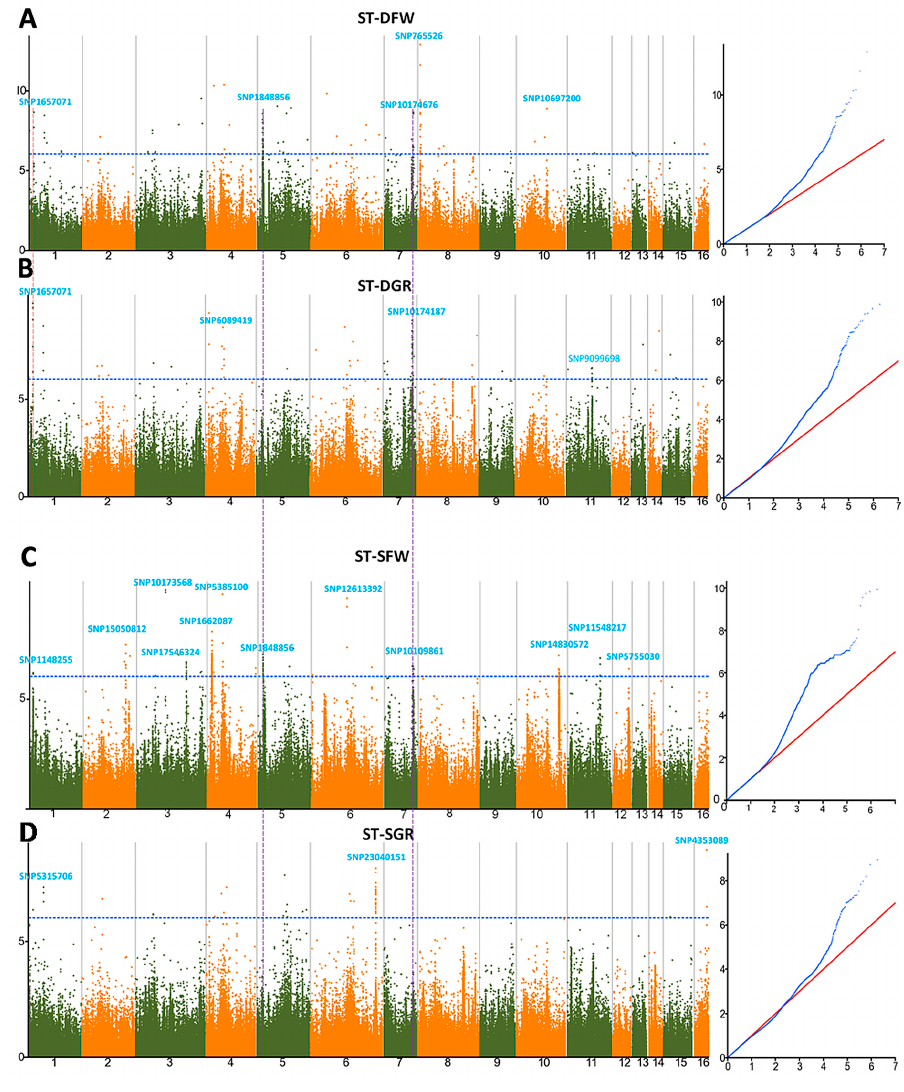
Figure 5. Manhattan plots and QQ plots of genome-wide association studies using the Mixed model for drought and salt tolerance indexes. ( A ) ST-DFW; ( B ) ST-DGR; ( C ) ST-SFW; ( D ) ST-SGR. The significant trait-associated QTLs commonly identified for the two indexes of the same stress are highlighted with dotted red lines and those commonly identified for drought and salt stresses are highlighted with dotted purple lines. QQ plot: Quantile-Quantile plots.